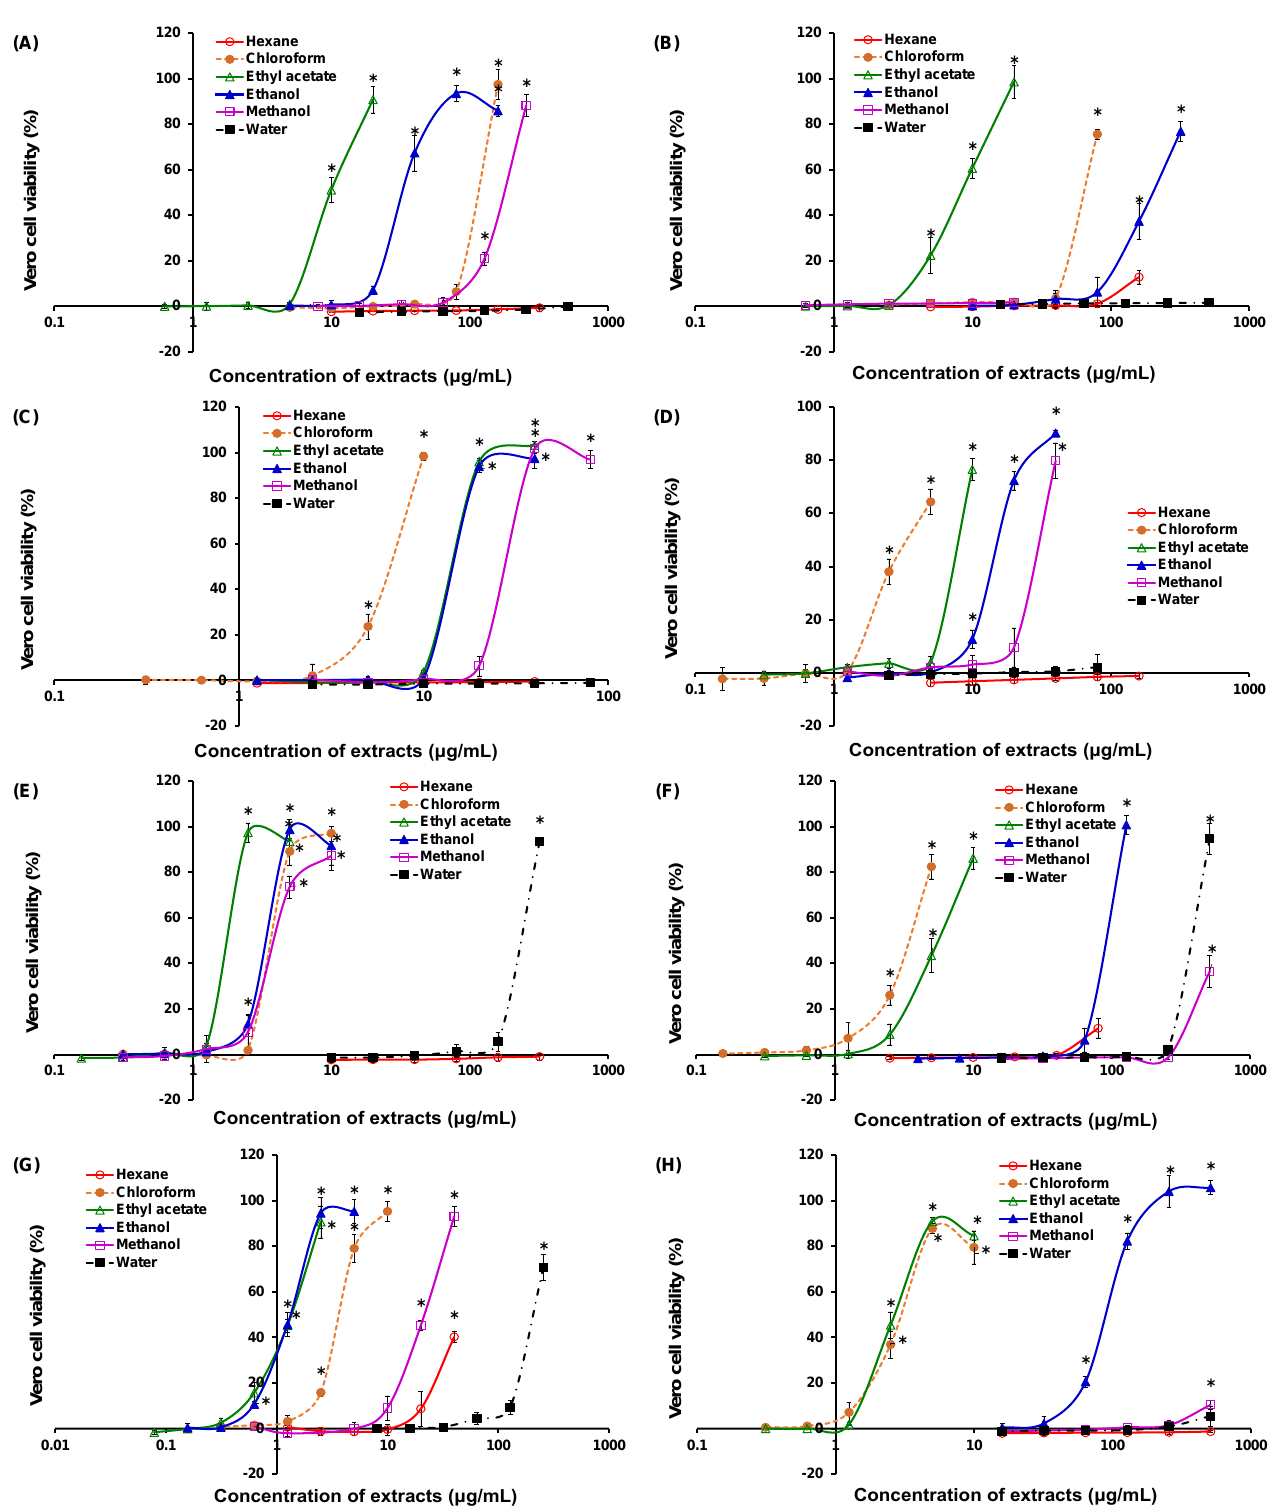
Figure 2. Viability of Vero cells infected by chikungunya virus and treated with different extracts of medicinal plants. ( A ) Clinacanthus nutans ; ( B ) Diodella sarmentosa ; ( C ) Diplazium esculentum ; ( D ) Ficus deltoidea ; ( E ) Gynura bicolor ; ( F ) Hydrocotyle sibthorpioides ; ( G ) Ocimum americanum ; ( H ) Sechium edule . All plants are shown for the concurrent mode except Ficus deltoidea , which is in the non-concurrent mode. The cell viability is measured using the neutral red uptake assay. The notated asterisks (*) denote significant differences ( p < 0.05) among concentrations within an extract by one-way ANOVA.